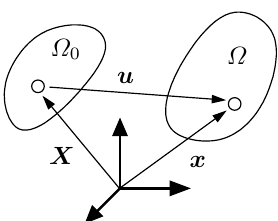
Figure 1. Initial ( Ω 0 ) and current ( Ω ) configuration, with elementary kinematic quantities. The displacement gradient H = u ⊗ ∇ X and the deformation gradient F = x ⊗ ∇ X are